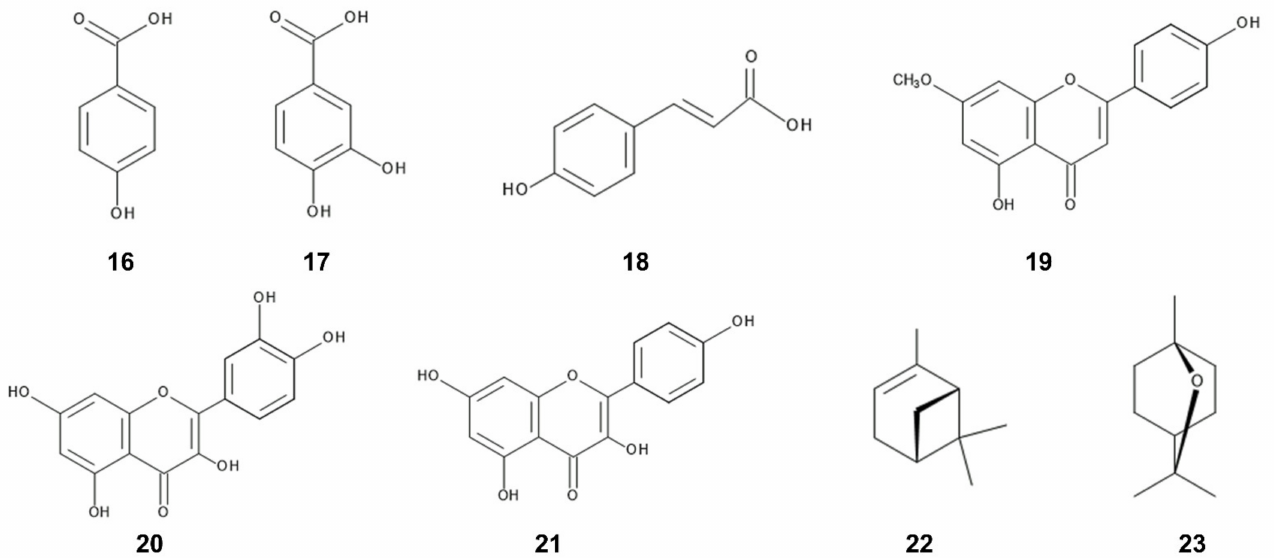
Figure 4. Potential allelochemicals; 16: p -hydroxybenzoic acid, 17: protocatechuic acid, 18: p -coumaric acid, 19: sakuranetin, 20: quercetin, 21: kaempferol, 22: α -pinene, 23: